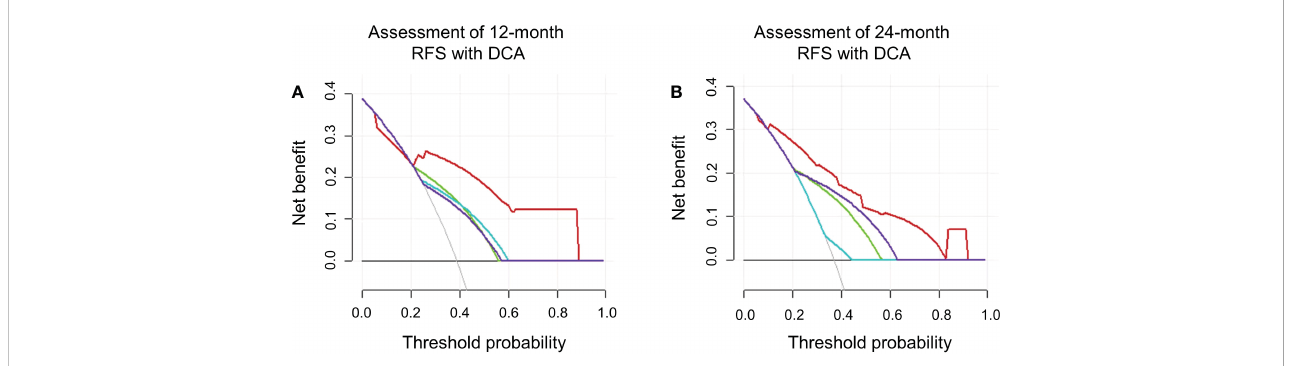
FIGURE 5 The decision curve analyses in terms of 12 (A) and 24 (B) months. RFS depicted integrated nomogram comprising the clinical feature (AFP) and LI-RADS v2018 imaging features on gadoxetic acid – enhanced MRI (rim APHE and targetoid restriction on DWI). Red line represents integrated nomogram (AFP + rim APHE + targetoid restriction on DWI); purple line represents targetoid restriction on DWI; green line represents AFP; blue line represents rim